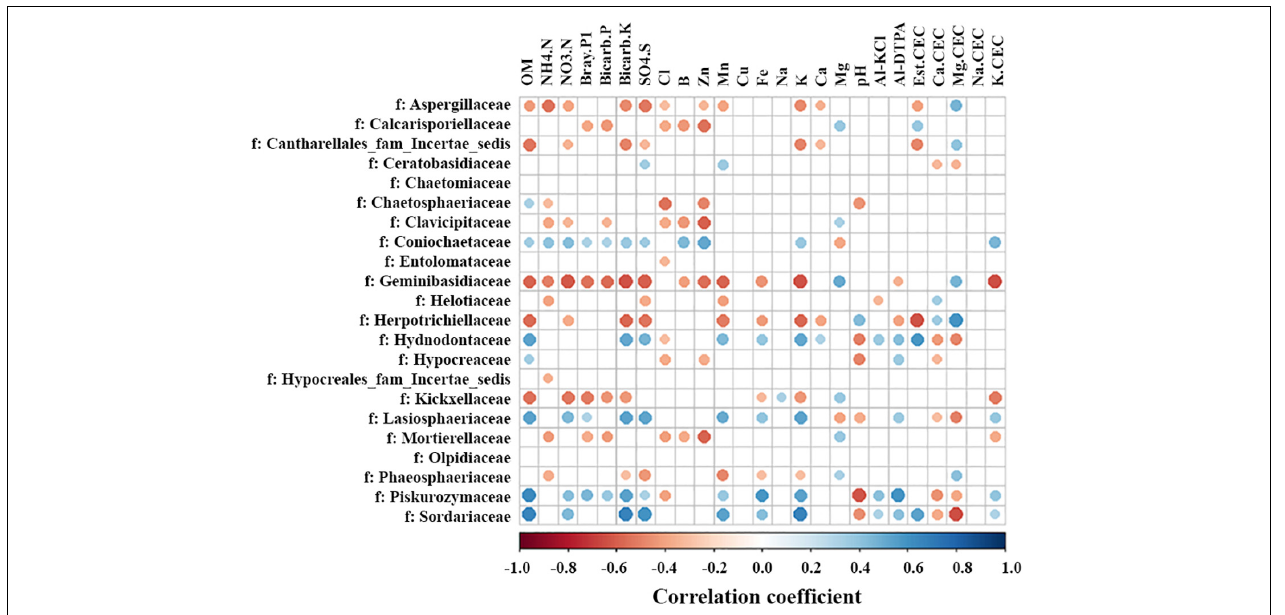
FIGURE 7 | Heatmap of significant spearman correlations between fungal family abundance and soil chemical characteristics. OM, organic matter; Al-KCl, KCl extractable aluminum; Al-DTPA, DTPA extractable aluminum; CEC, cation exchange capacity and the element listed before CEC (i.e., Ca.CEC) represents the proportion of the CEC comprised of that specific cation. Significance was examined using R statistical software ( p ≤ 0.05 and absolute r -value cut off